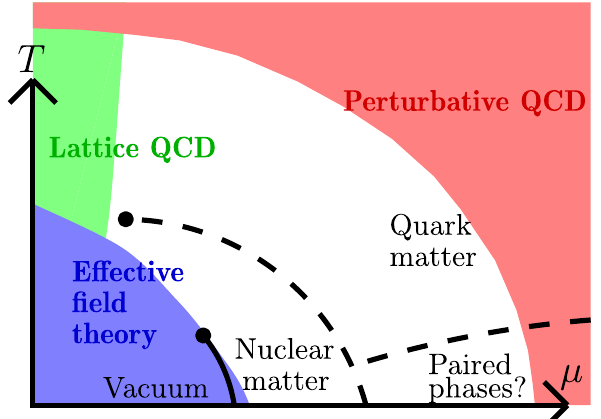
Fig. 1 A simple sketch of the (possible) QCD phase diagram as a function of quark chemical potential and temperature. The black curves are first order phase transitions ending at critical points. The colored regions show roughly the ranges of applicability of various theoretical and computational methods. We stress the fact that the existence of the nuclear to quark matter transition and the transition to “exotic” phases are still open questions by marking them by dashed